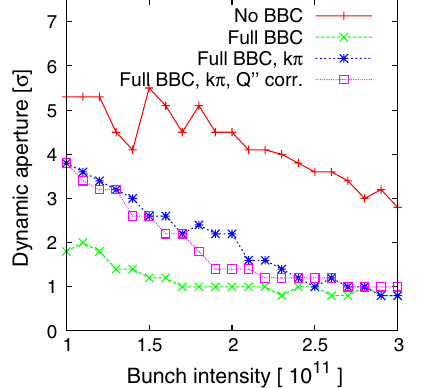
FIG. 10. Dynamic apertures of full head-on beam-beam com- pensation with the betatron phase advance adjustment and the global second order chromaticity correction.